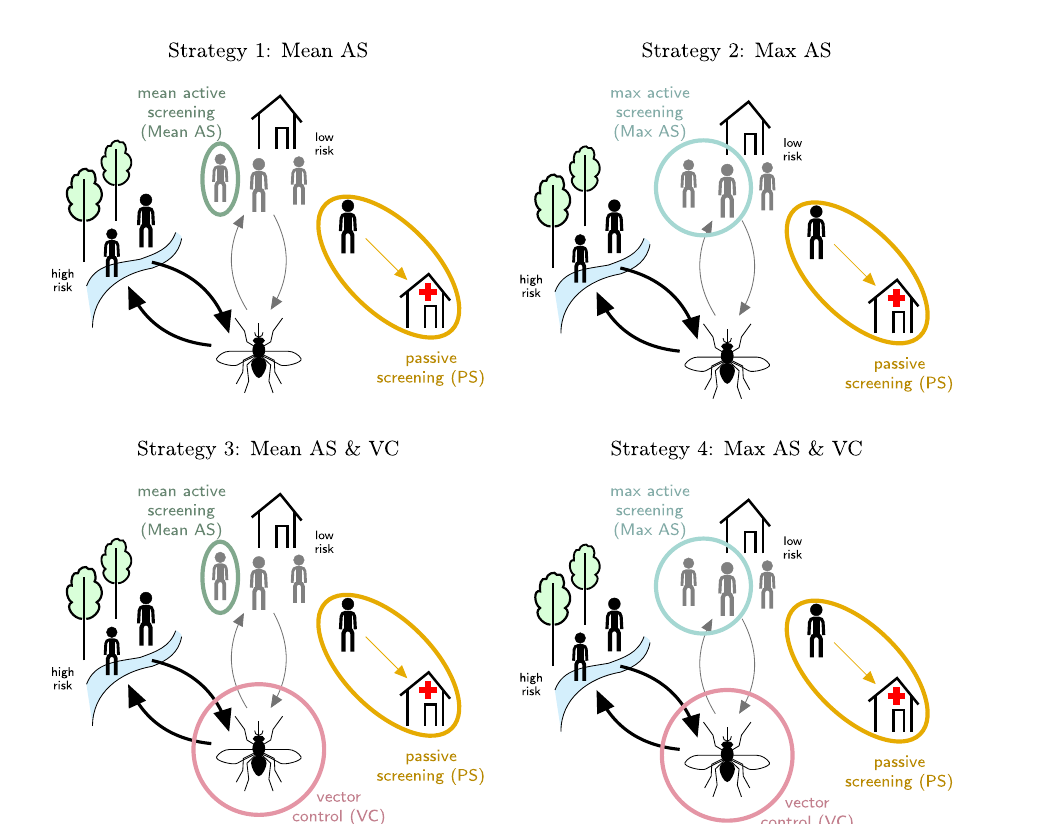
Fig. 1 Model of strategies against gHAT in the Democratic Republic of Congo (DRC). Strategies against gHAT, including active screening (AS) by mobile teams, passive screening (PS) in fi xed health facilities, and vector control (VC). In two strategies ( “ Mean AS ” and “ Mean AS & VC ” ) the proportion screened equalled the mean number screened during 2014 – 2018. In two other strategies ( “ Max AS ” and “ Max AS & VC ” ), the coverage is the maximum number screened in the period of 2000 – 2018. In strategies 3 and 4, VC is simulated assuming an 80% tsetse density reduction in one year, except in Yasa Bonga, where the reduction of tsetse density was estimated at 90% in the literature 9 . PS is in place under all strategies. This fi gure has been adapted from 24 under a CC-BY